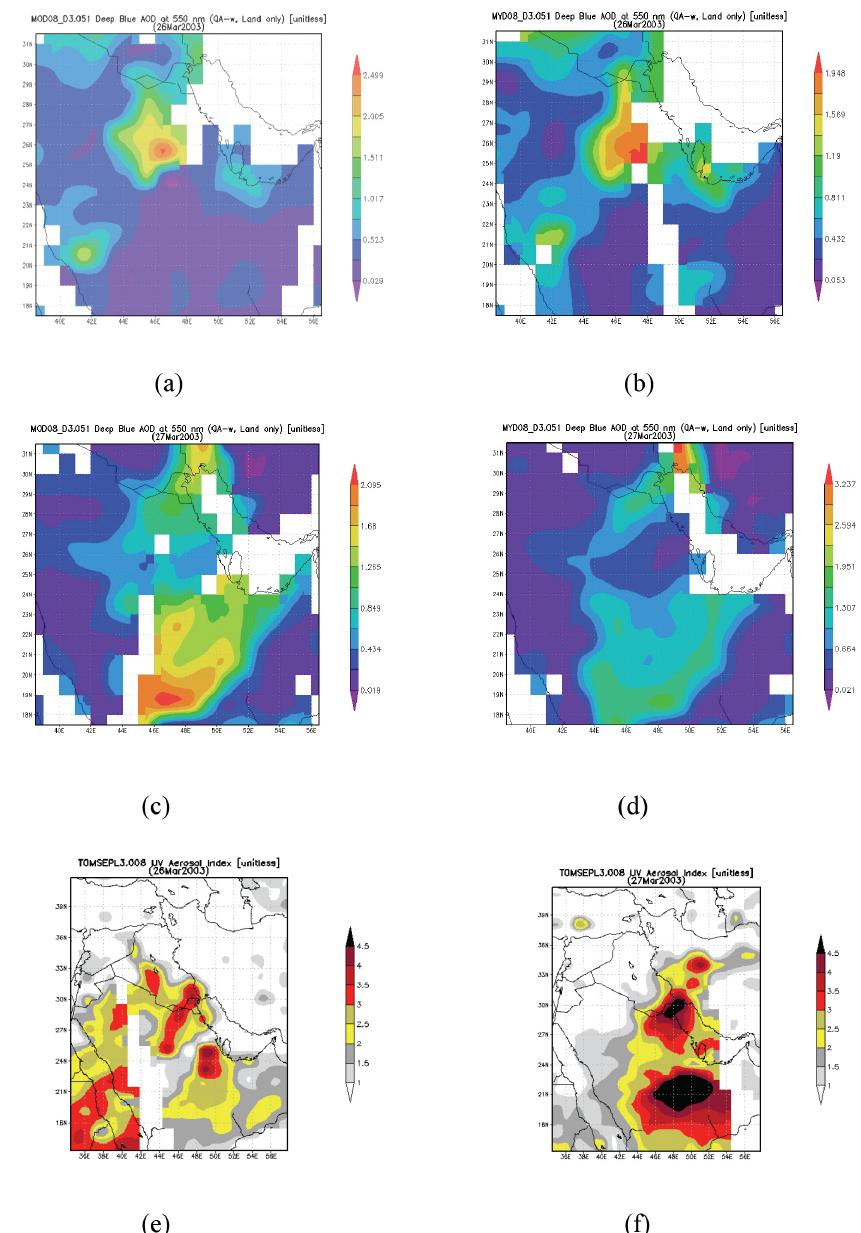
Fig. 9. MODIS Deep Blue algorithm retrieval of AOD 550 over the Arabian Peninsula on 26 March for Terra satellite (a) , Aqua satellite (b) , and on 27 March for Terra satellite (c) , Aqua satellite (d) . TOMS AI field distribution across the Arabian Peninsula for the 26 March dust storm (e) and 27 March (f)